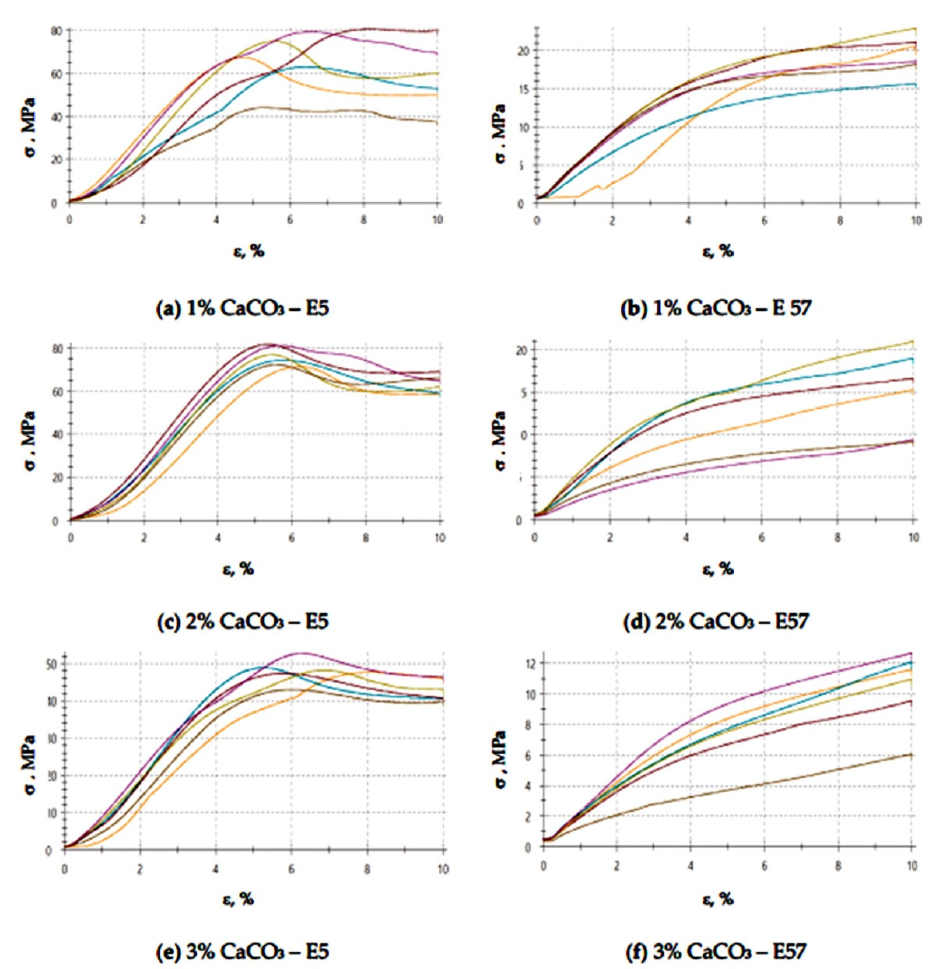
Figure 22. Stress–strain curves of the E5 / PAC / 100:80 and E57 / PAC / 100:80 epoxy specimens modified by the calcium carbonate filler post-thermal shock chamber aging: ( a ) 1% CaCO 3 —E5, ( b ) 1% CaCO 3 —E57, ( c ) 2% CaCO 3 —E5, ( d ) 2% CaCO 3 —E57, ( e ) 3% CaCO 3 —E5, ( f ) 3% CaCO 3 —E57.